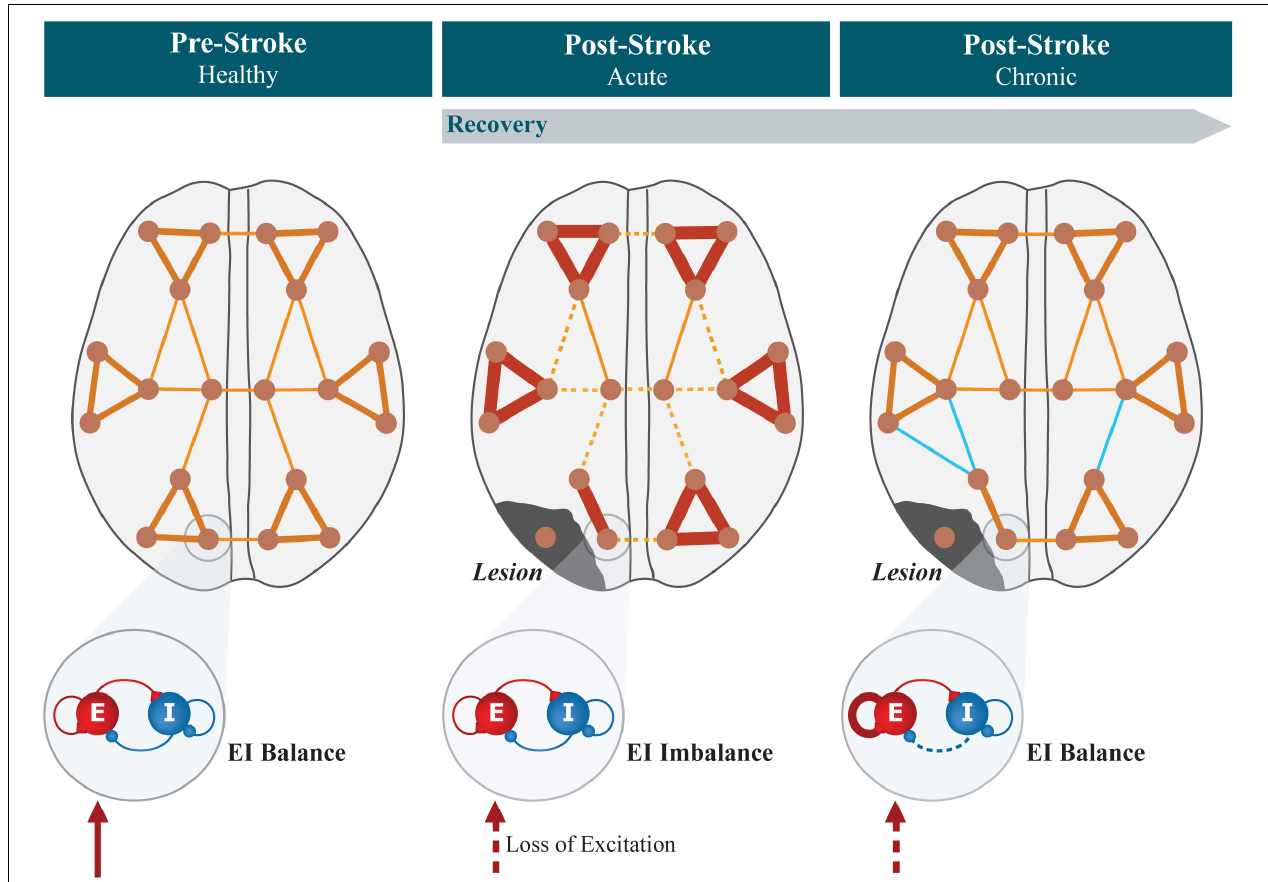
FIGURE 4 | Summary of the evolution of connectivity and local EI balance in cortical networks after stroke. In the healthy brain, functional networks show a modular structure, with strongly connected regions forming modules, connected by functional hubs. Excitatory and inhibitory synapses are regulated locally by EI homeostasis so that balance is maintained, accounting for the level of excitation received from external sources and keeping neuronal firing rates stable. Focal lesions experienced by stroke patients lead to neural tissue necrosis in confined areas. In the acute period after lesion, the modular organization of functional networks is disrupted, showing increased segregation between modules, together with decreased interhemispheric and increased intrahemispheric connectivity. Simultaneously, areas that previously received white matter projections from the lesioned region experience a sudden reduction in the levels of external excitation, causing a local imbalance in excitatory and inhibitory activity. During the process of recovery, synaptic plasticity compensates for the reduced excitation by increasing/decreasing the strength of excitatory/inhibitory synapses unto pyramidal neurons, increasing their excitability to restore local EI balance. Concurrently, functional connectivity changes toward pre-lesion levels, either through the recovery of healthy functional networks or via cortical reorganization and the formation of new functional pathways (represented in light